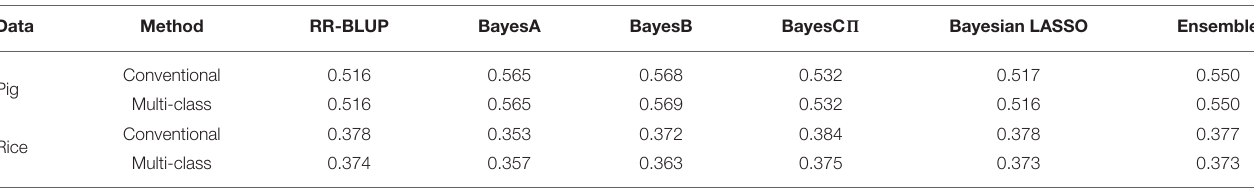
The comparison of mean prediction accuracy on the trait 13-week tenth rib backfat (mm) from pig data and trait FTA of rice real data across 50 validation datasets between multi-class Bayesian Alphabet using genome annotation information and conventional Bayesian Alphabet. The paired t-test (p < 0.1) was used to declare the significant difference. No significant differences were found between multi-class and conventional Bayesian Alphabet methods for both real pig and rice data (p < 0.1).